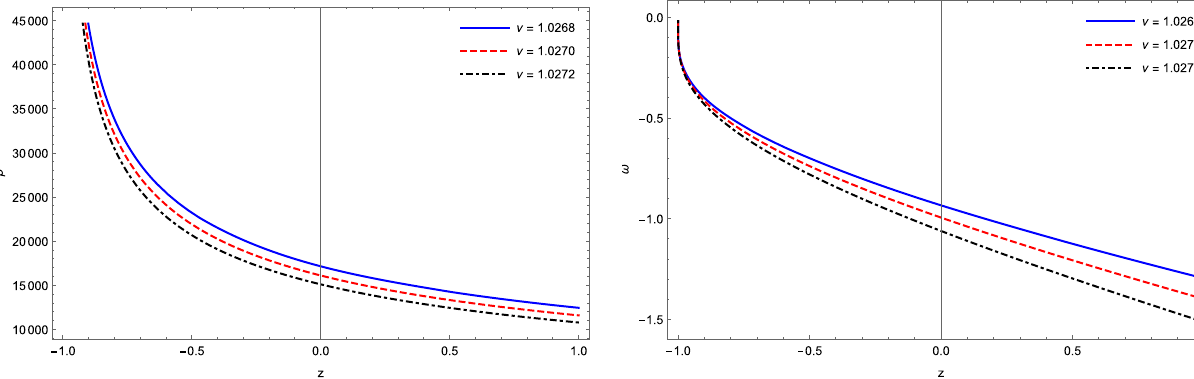
Fig. 2 Effective energy density (left panel) and EoS parameter (right panel) in redshift. The parameter scheme: α = 0 . 21 ,β = 0 . 0000208